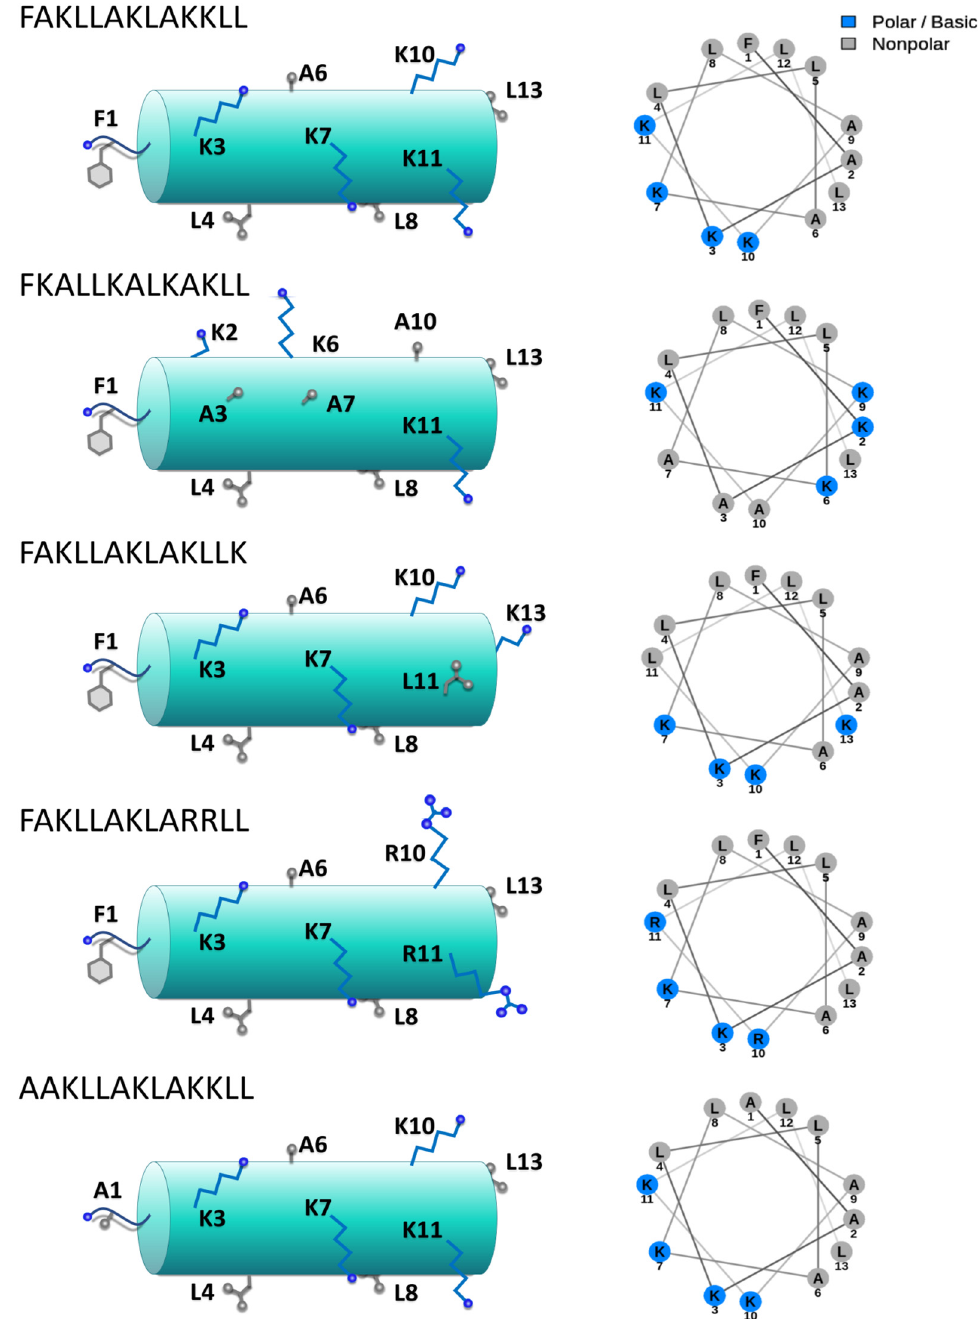
Figure 2. Schematic representation of HB43 and mutants ( left ) and their respective helical-wheel projections representing alpha-helix structures ( right ). Hydrophobic amino acids are represented in gray and those with a positive charge (K, R) in blue. Diagrams were created with NetWheels [ 82 ] .